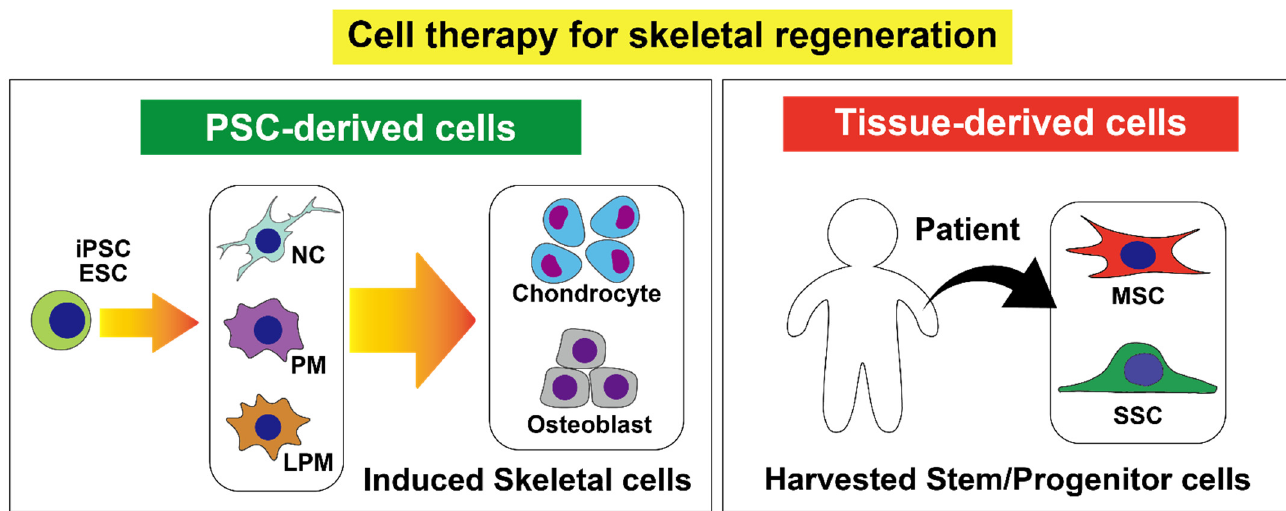
Figure 1. Summary of cell therapy in skeletal regeneration. PSC, pluripotent stem cell; iPSC, induced pluripotent stem cell; ESC, embryonic stem cell; NC, neural crest; PM, paraxial mesoderm; LPM, lateral plate mesoderm; MSC, mesenchymal stem/stromal cell; SSC, skeletal stem cell.